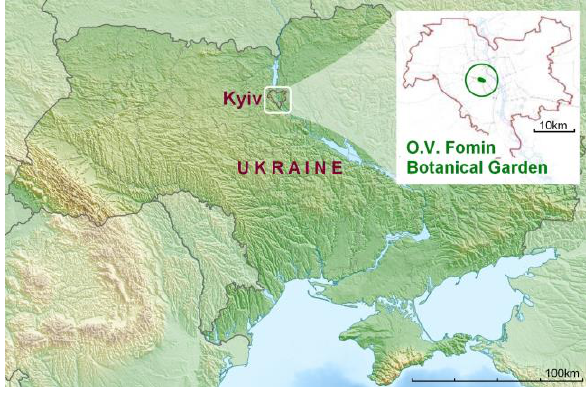
Fig. 1. Location map of the Botanical